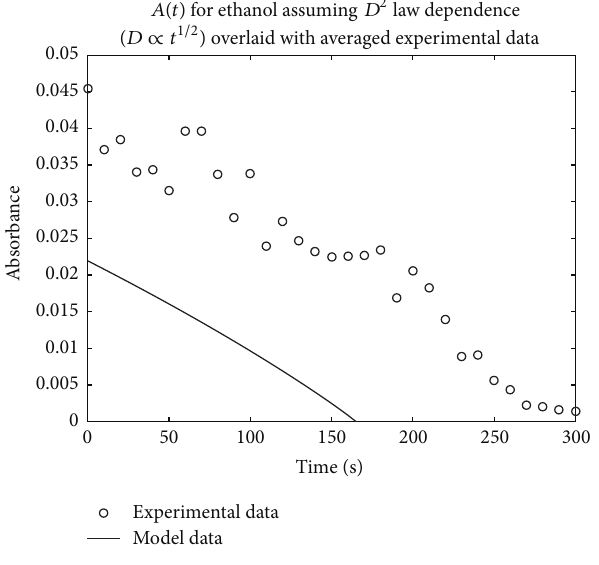
Figure 4: Single component droplet evaporation comparing the experimental data from IR absorption spectroscopy of our model for 100% ethanol. Data shown were averaged over five